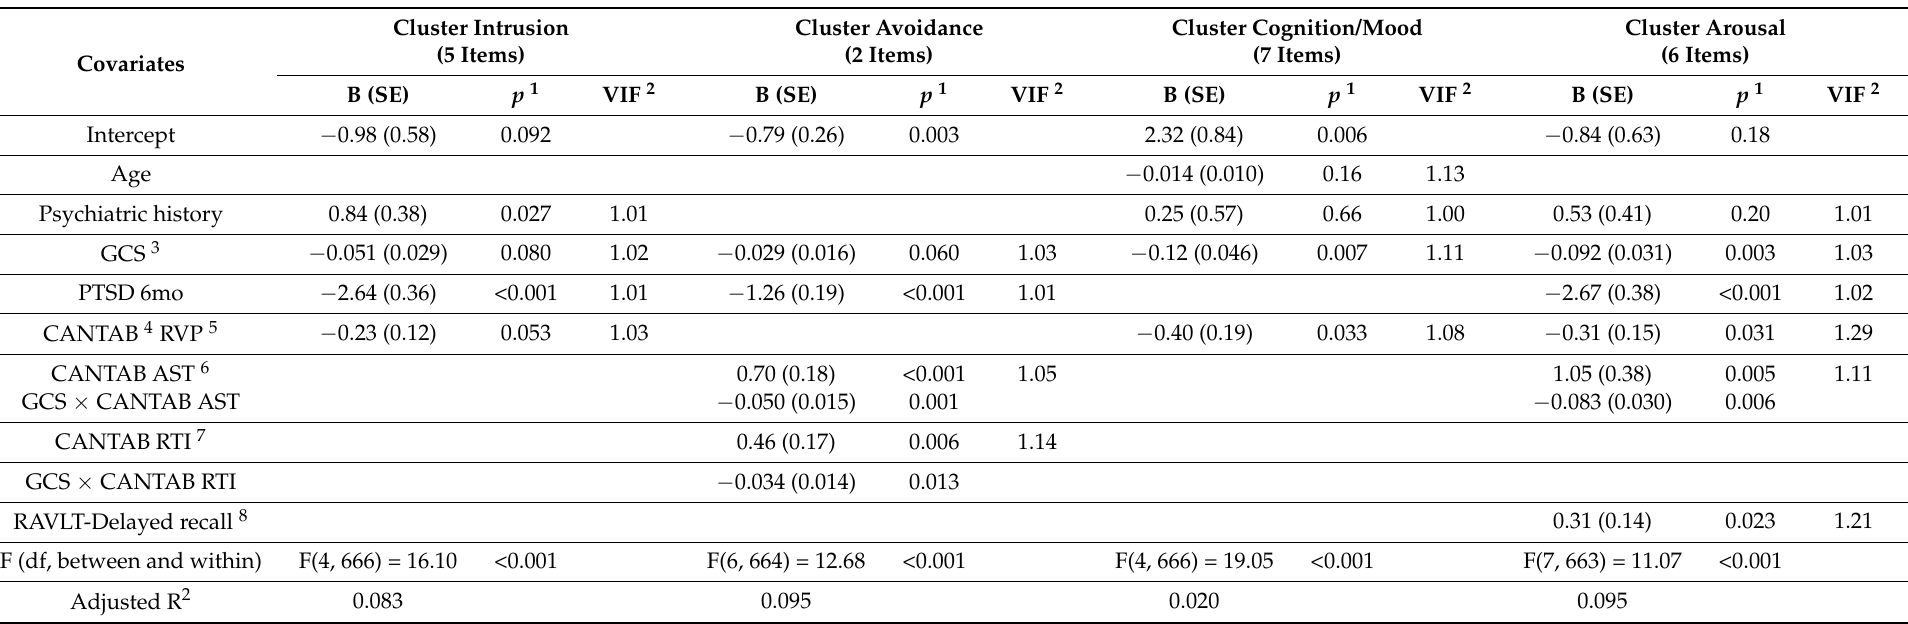
Table 3. Linear regression analyses: covariates associated with PCL-5 cluster change